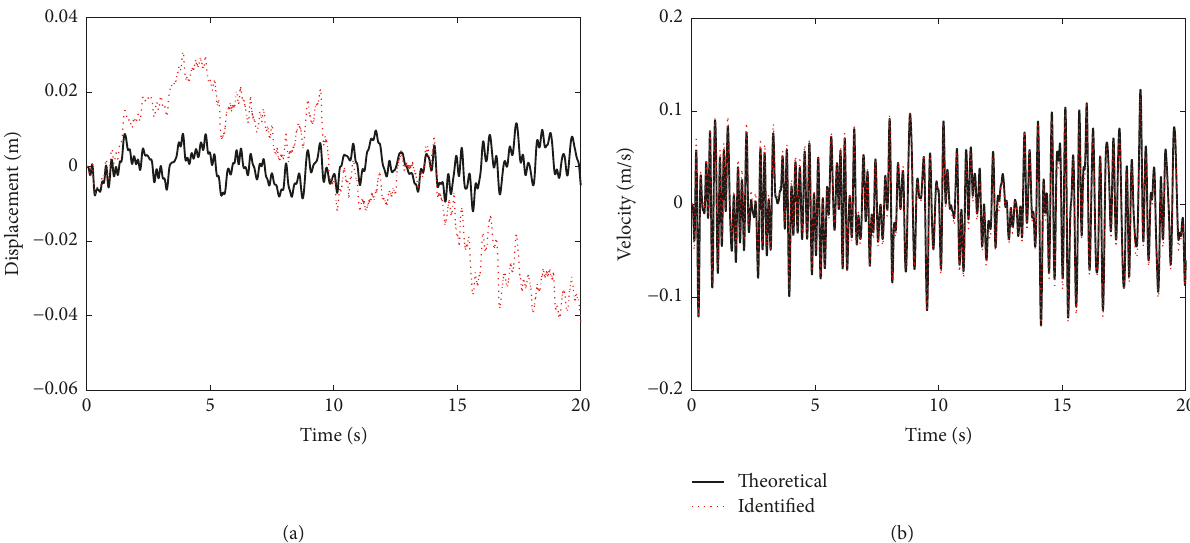
Figure 4: (a) The theoretical and identified vertical displacement at Node 7. (b) The theoretical and identified vertical velocity at Node 7.